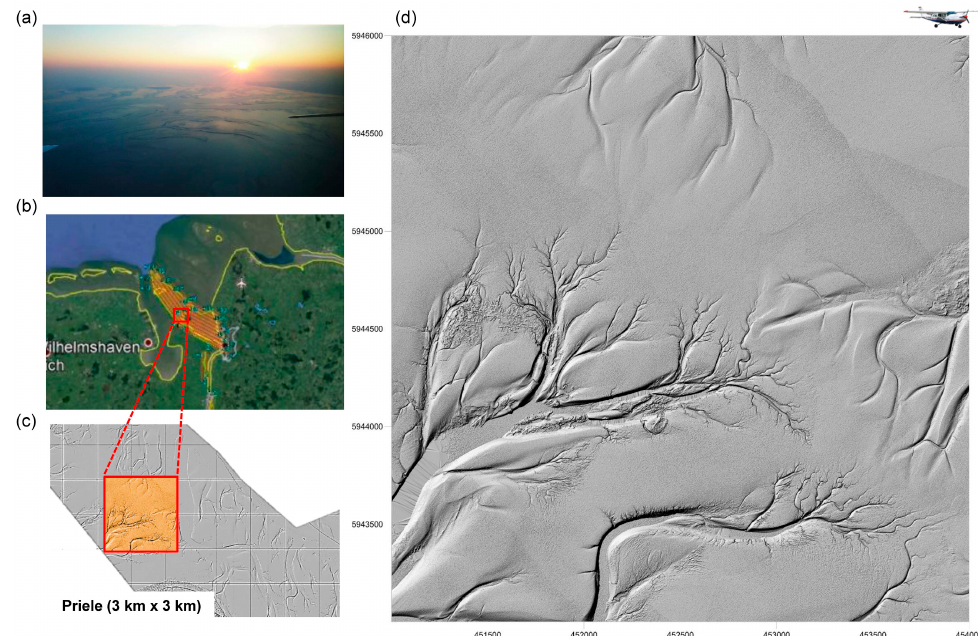
Figure 10. Tideways in the Weser river, northeast of Wilhelmshaven, Germany: ( a ) Photo of the tideways acquired from the airplane. ( b ) Location (Google Maps) of the monitored area (in orange) ( c ) Digital Elevation Model (DEM) created by Airborne Laser Scanning (ALS) with a blue rectangle (>5 LMW/m 2 ), highlighting the location of the ( d ) 3 × 3 km tideways displayed as shaded relief (elevation of the contours Z = 20).